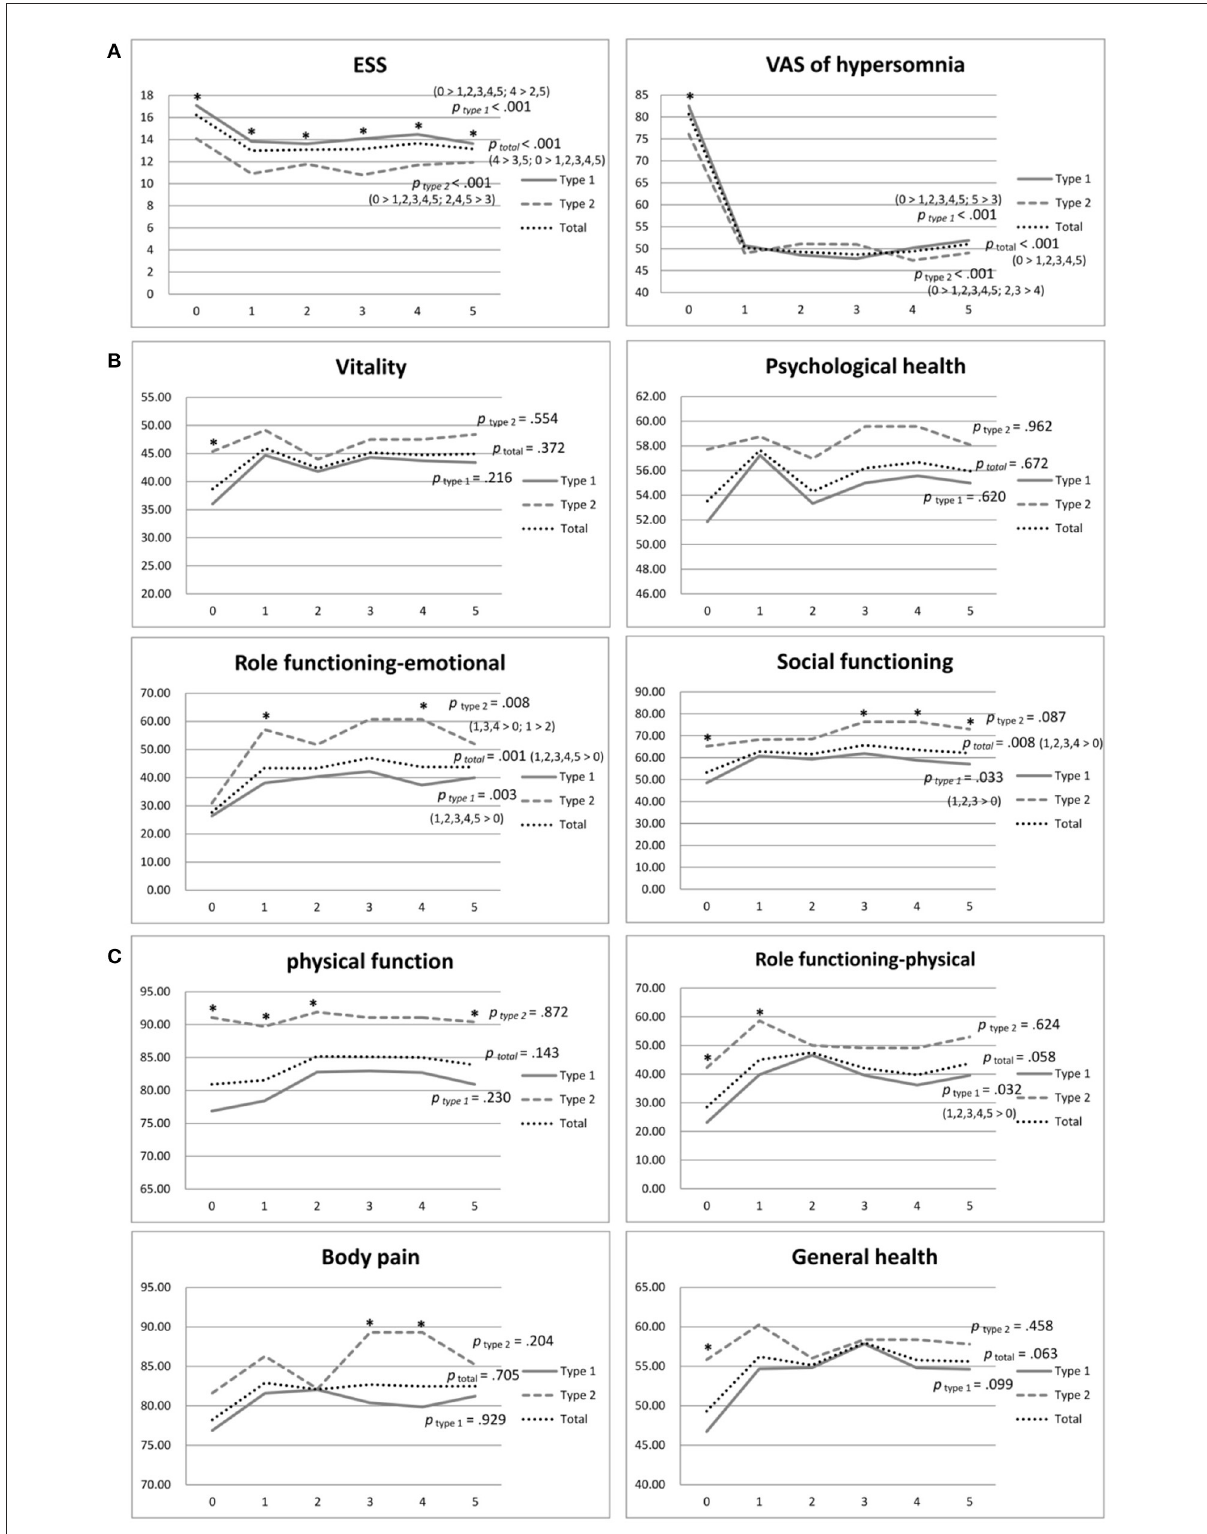
FIGURE2 (A) Physical domains of SF-36 of narcolepsy type 1, narcolepsy type 2, and total participants during the 5-year follow-up. * p < 0.05. (B) Psychological domains of SF-36 of narcolepsy type 1, narcolepsy type 2, and total participants during the 5-year follow-up. * p value < 0.05. (C) ESS and VAS of narcolepsy type 1, narcolepsy type 2, and total participants during the 5-year follow-up. * p value < 0.05. ESS, Epworth Sleepiness Scale; VAS, Visual Analog Scale for